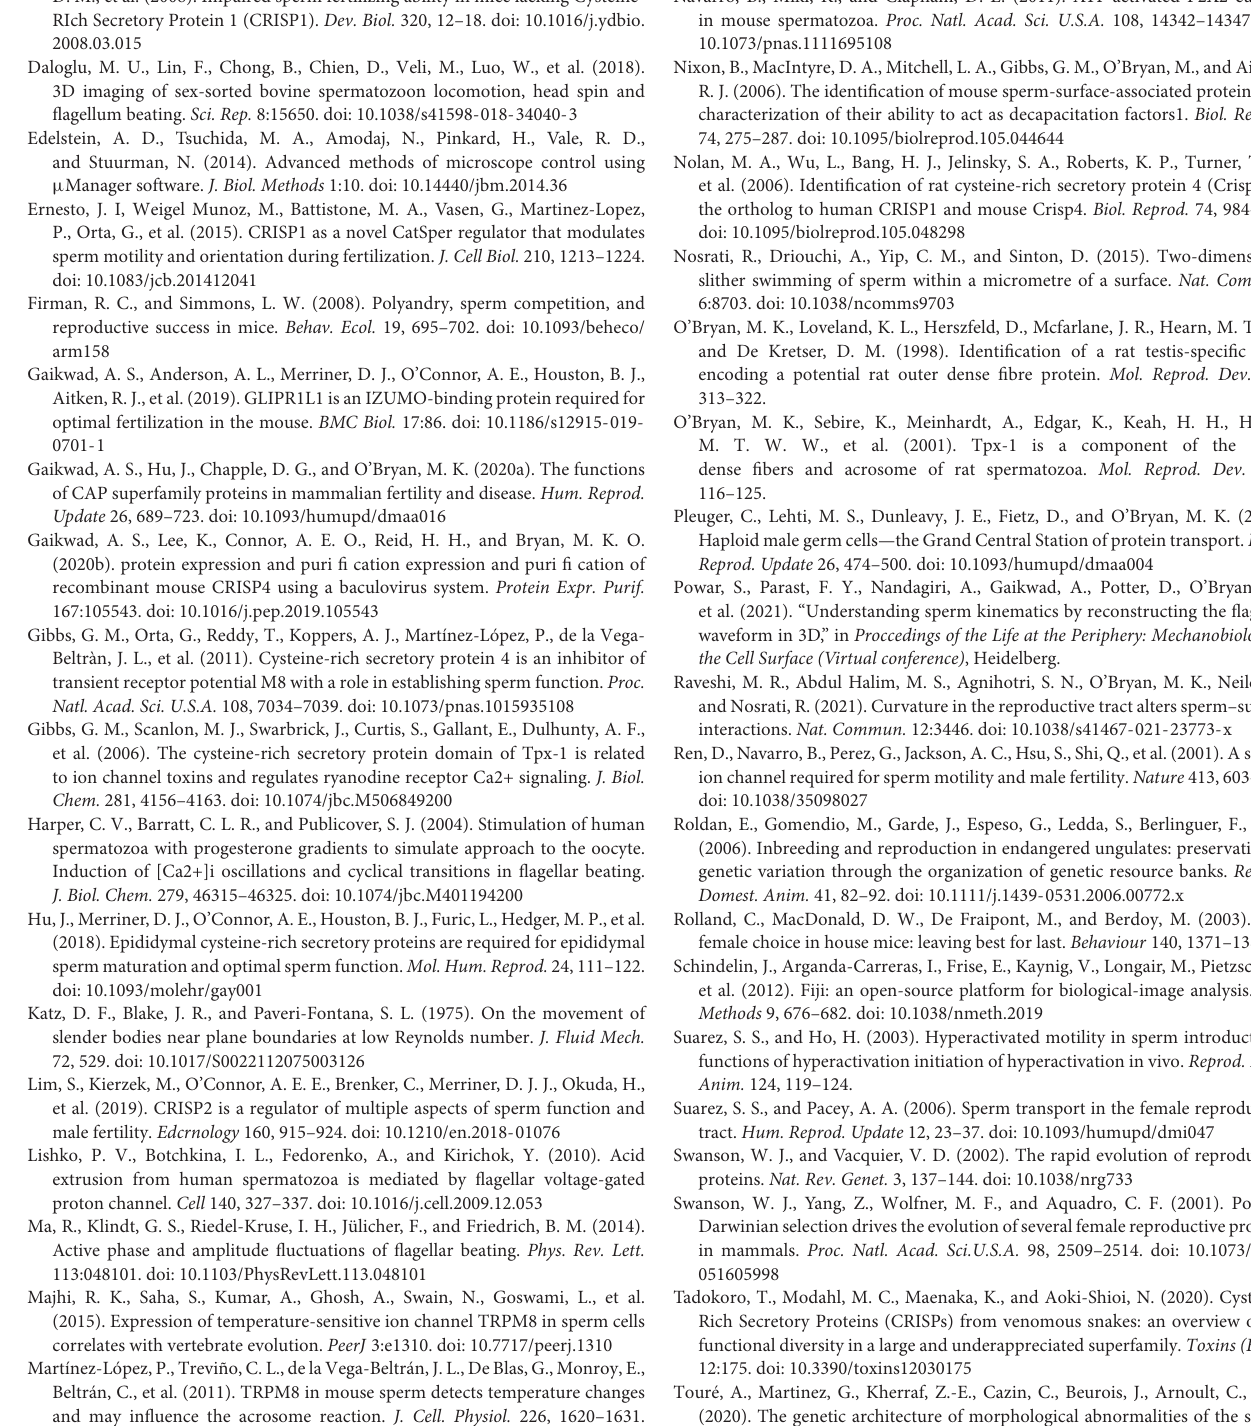
12:175. doi: 10.3390/toxins12030175 Touré, A., Martinez, G., Kherraf, Z.-E., Cazin, C., Beurois, J., Arnoult, C., et al. (2020). The genetic architecture of morphological abnormalities of the sperm tail. Hum. Genet. 140, 21–42. doi: 10.1007/s00439-020-02113-x